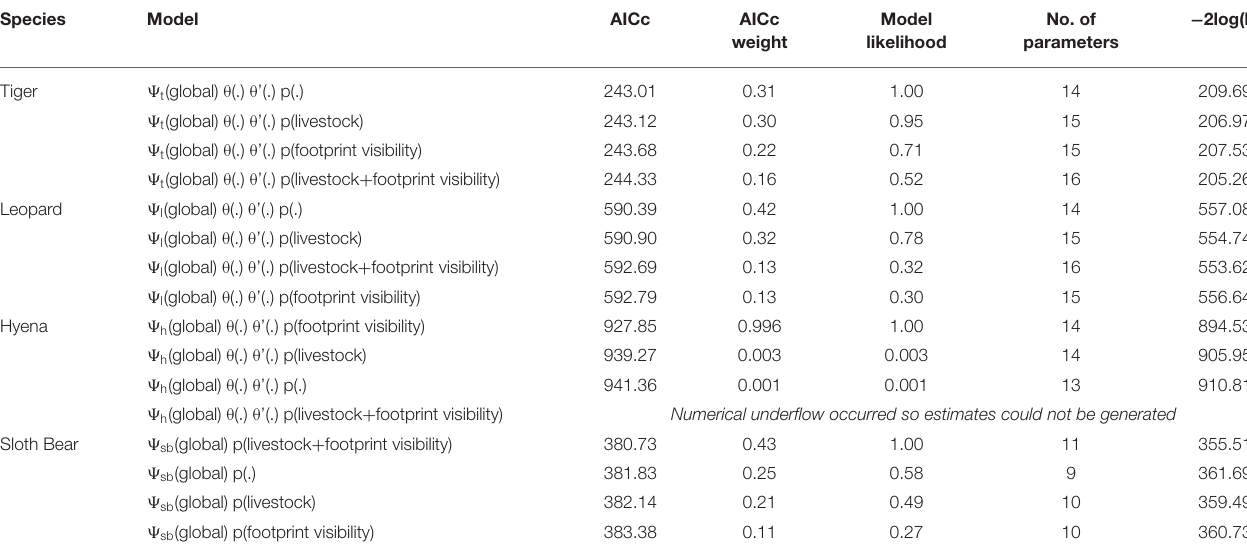
TABLE 1 | Model comparisons to estimate detection probability as a function of observer footprint visibility and livestock. Species